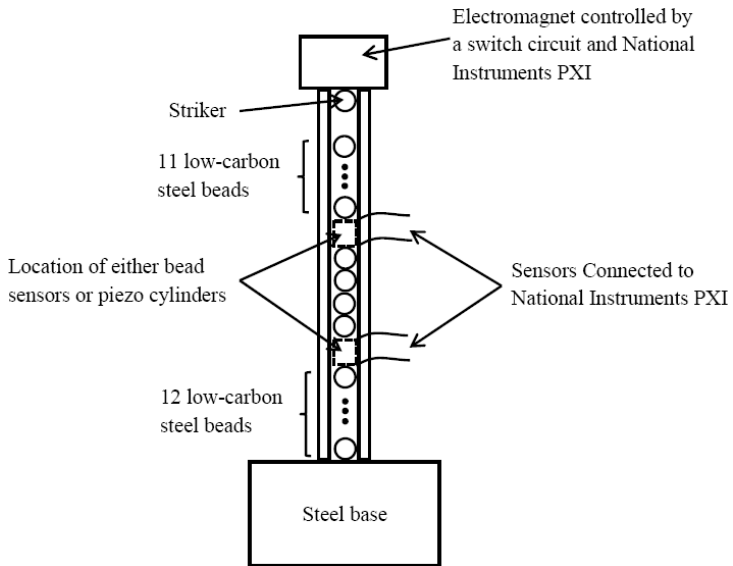
Figure 1. Schematic diagram of the experimental